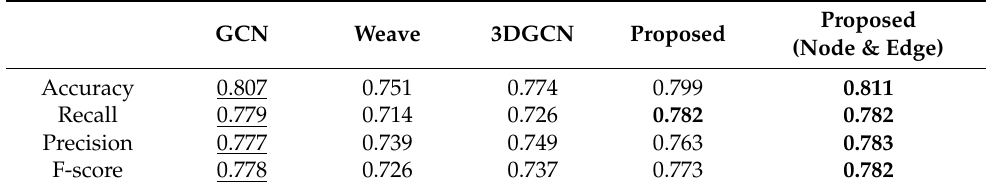
Table 6. Classification results on BACE (Bold and underline are the best and the second-best, respectively).